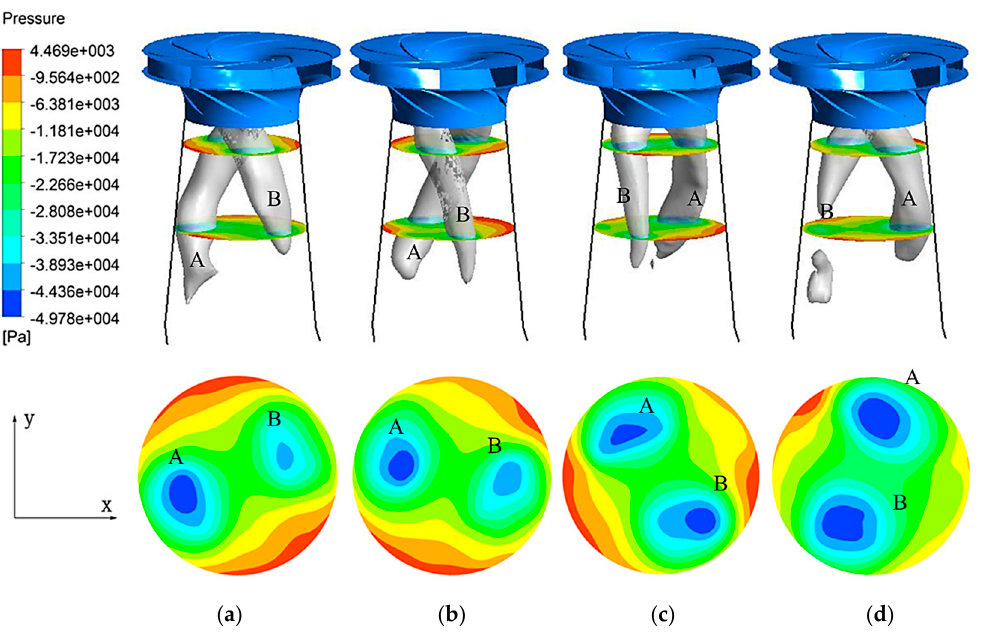
Figure 8. Twin vortex rope in the draft tube at OP3: ( a ) t = t 0 ; ( b ) t = t 0 + 1/3 T ; ( c ) t = t 0 + 2/3 T ; and ( d ) t = t 0 + T .